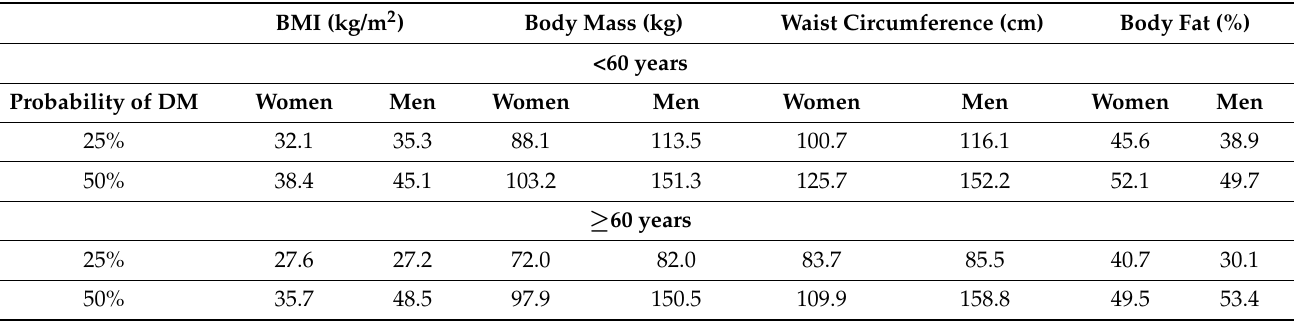
Table 3. The corresponding age- and sex-specific values of anthropometric measurements and estimated body fat for 25% and 50% of the probability of diabetes occurrence (according to logistic- regression